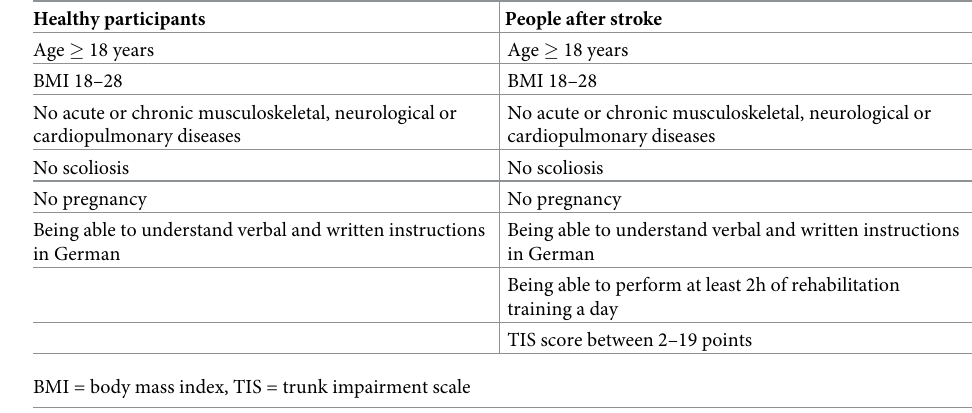
Table 1. Inclusion